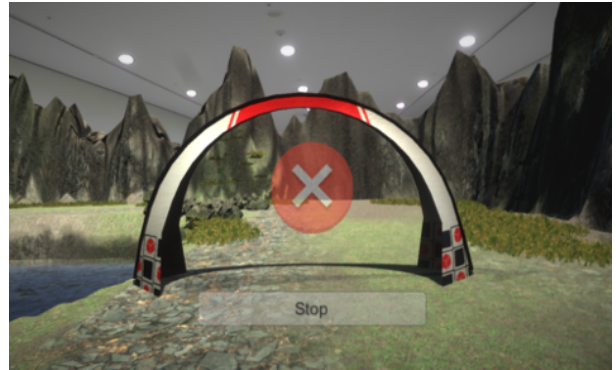
Figure 19. Icon annotation displayed on the HMD of a drone